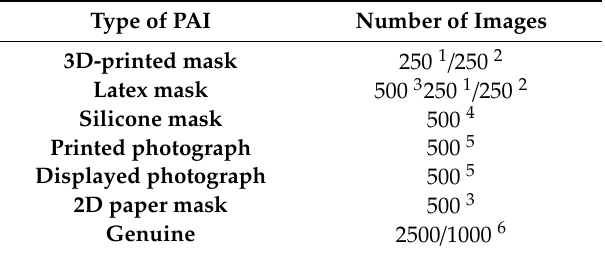
Figure 6. Gallery of images from ( a , b ) the MLFP database, latex masks ( c ) MLFP database, 2D paper mask and ( d – f ) CSMAD database. Table 3. Number of images in respective datasets.